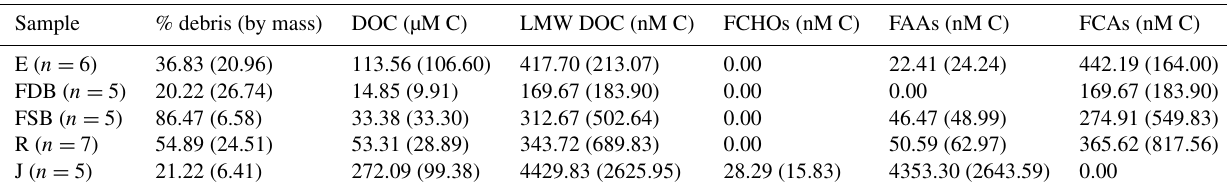
Table 1. Biogeochemical data for basal ice from Engabreen (E), Finsterwalderbreen (F), Russell Glacier (R), and Joyce Glacier (J). DB indicates dispersed banded and SB solid banded. Values given are the mean concentrations for each analyte, and the standard deviation is given in parentheses. LMW-DOC is free carbohydrates (FCHOs) + free amino acids (FAAs) + free carboxylic acids (FCAs). Only values >LOQ have been included.